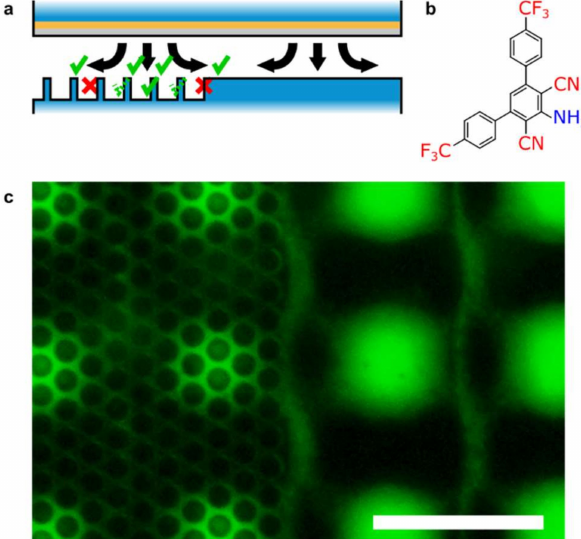
Figure 3. Material flow over and into micro-structures. ( a ) Schematic sketch of the experiment; ( b ) Structure of the applied fluorescent compound [9]; ( c ) Actual fluorescent image of the deposition pattern, in green color scale. The pattern on top of the structured substrate is similar to the result on a flat surface, but the bottom of the micro-wells was reached by the material flow and stained only in the center region of the spots. The diameter of the cavities was 23 µ m, their smallest distance 9.5 µ m, and their depth 8.7 µ m. The scale bar represents 250 µ